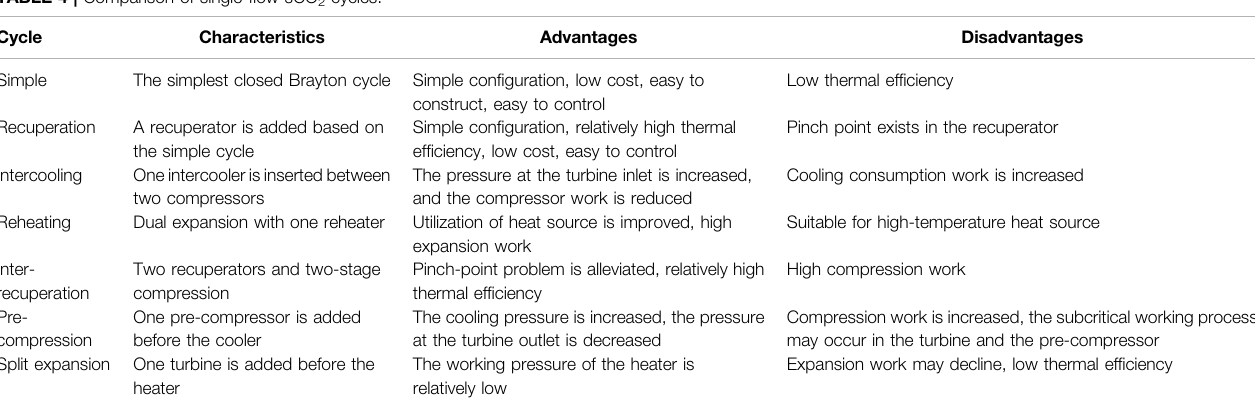
TABLE 4 | Comparison of single- fl ow sCO 2 cycles.